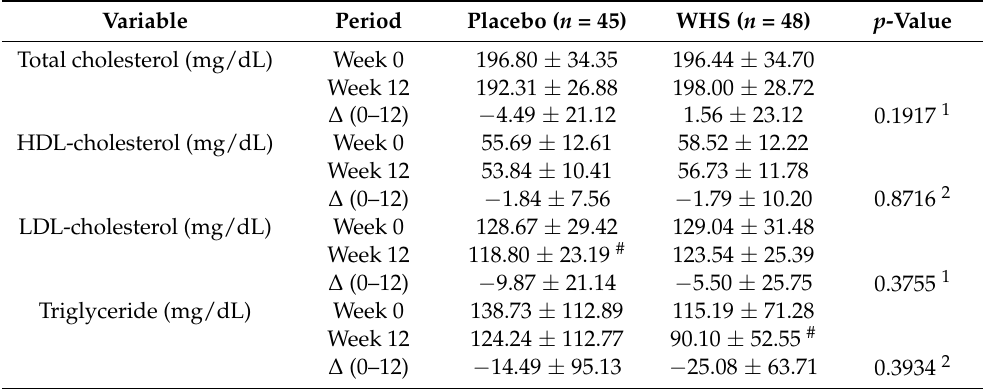
Table 2. Lipid profiles of subjects.